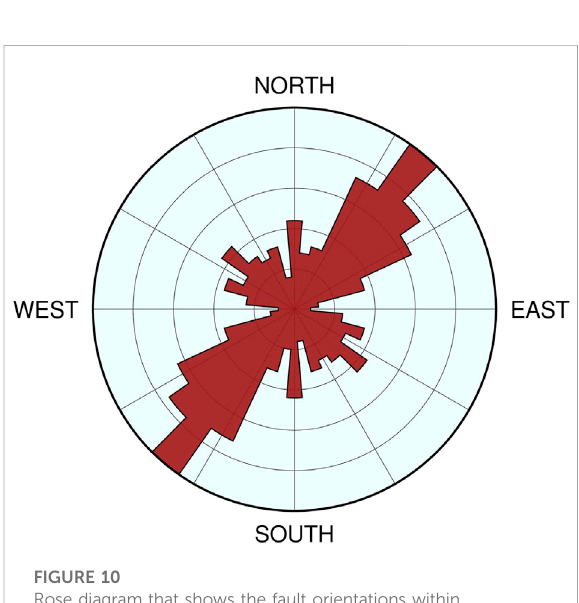
FIGURE 10 Rose diagram that shows the fault orientations within Southern